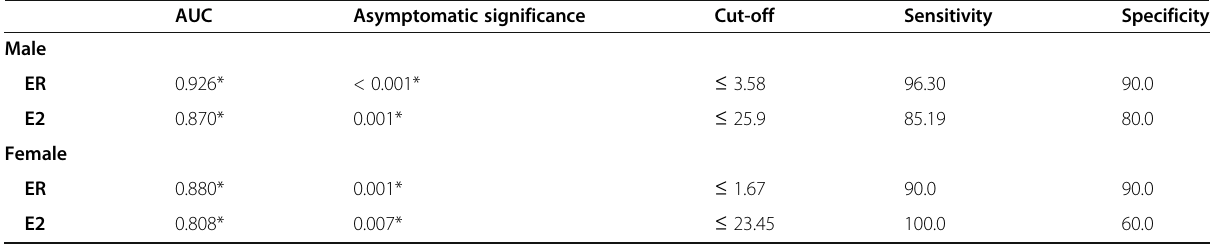
Table 7 ROC curves analysis of serum ER (ng/ml) and E2 (pg/ml) in AML and ALL male/female patients